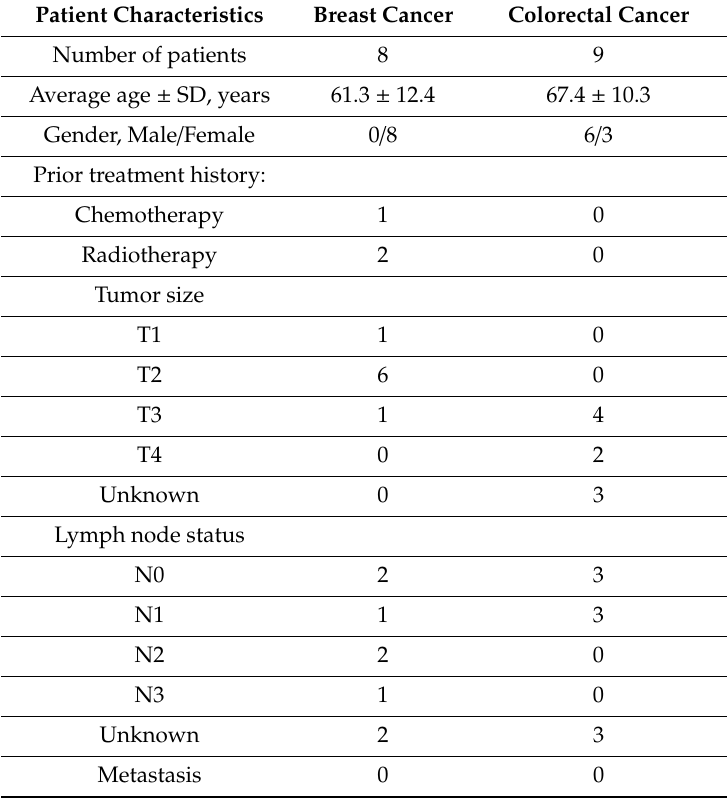
Table 1. Patient